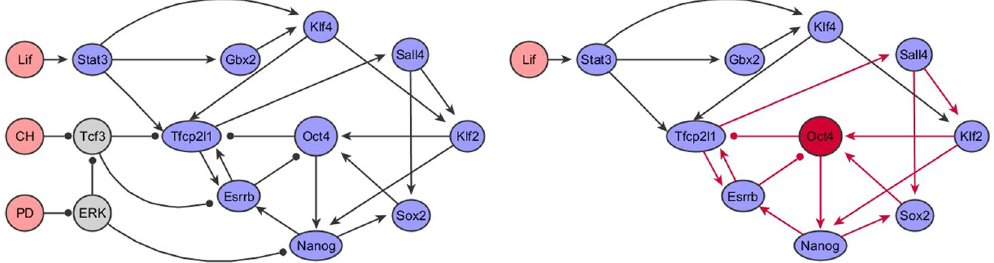
Figure 1. (Left) The regulatory network for pluripotency derived by Dunn and co-workers in ref. 34. (Right) The reduced network that we study here in which Lif is taken as a noisy input and Oct4 is taken as the target. Since CH and PD cannot be reached from Lif via a walk on this network, we can exclude these nodes, along with Tcf3 and ERK, from our analysis. Edges that participate in feedback loops in the network are shown in red.